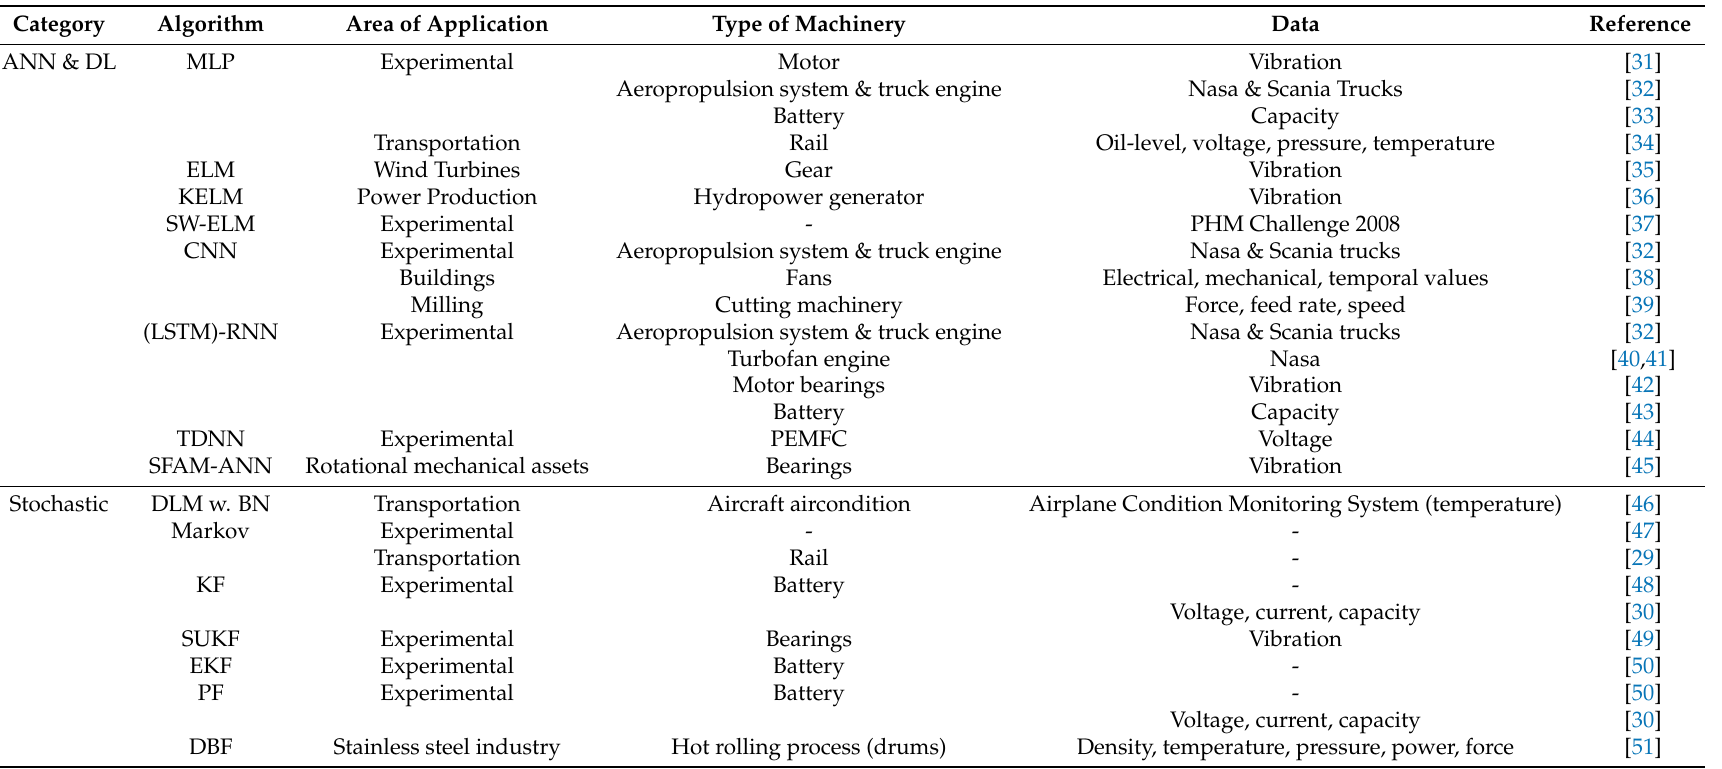
Table 2. A list of studied papers categorised by the characteristics of the algorithm applied. The list is an effort on displaying what is moving within the field, but does not reflect all available